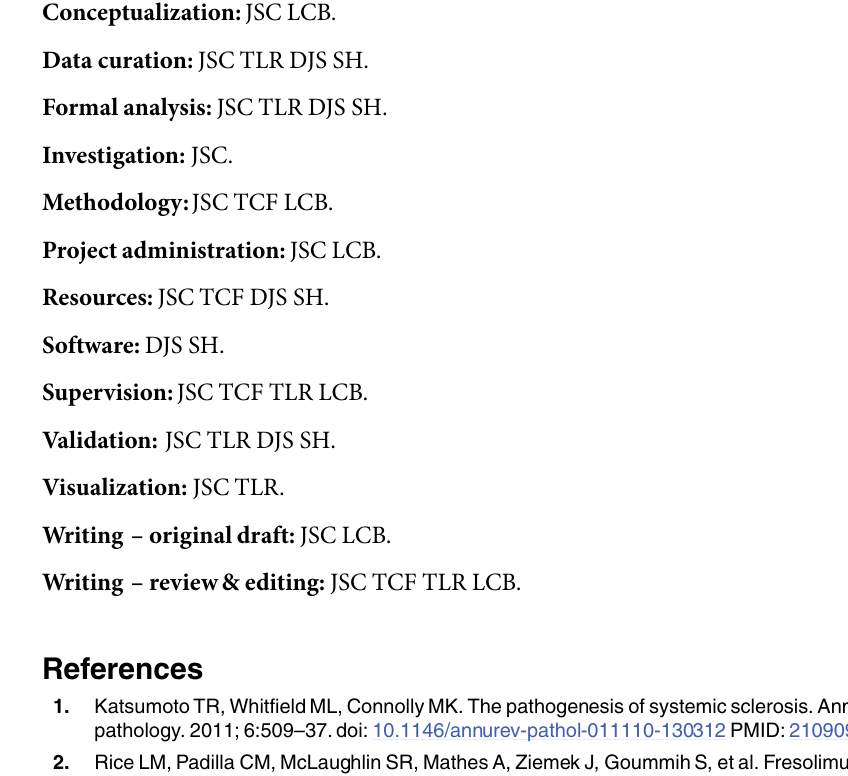
S7 Fig. Spearman rank correlation and ROC analysis of monocyte/macrophage cell recruit- ment and vessel density with ulceration area. (A-B) A scatter plot of all treatment groups that were analyzed by spearman rank correlation is shown for IBA-1 (A) and CD31 (B) percent area immunoreactivity compared to area of ulceration (r = 0.56 for IBA-1 and r = 0.33 for s s CD31). (C) The logistic regression and ROC curve analyses were applied to evaluate the predic- tive accuracy of IBA-1, CD31, or the combination of IBA-1 and CD31 percent area immunore- activity for presence or absence of ulceration. P -values were calculated relative to the null hypothesis for IBA-1 and CD31 or relative to IBA-1 alone for the combination of IBA-1 and CD31 percent area. N = 8 samples per group, two independent studies, 104 total data points. (cid:3) P -value relative to IBA-1 percent area alone. (TIF) S8 Fig. Expression of ISGs in lesional skin biopsies obtained from wildtypeand IFNAR- deficient mice. Relative mRNA expression levels of MX1 , RSAD2 , IRF7 , or MDA5 from lesional skin homogenates of skin biopsies performed by Q-PCR on days 3 (top) or day 21 (bottom) of treatment regimen. (cid:3) P < 0.05, (cid:3)(cid:3) P < 0.01, (cid:3)(cid:3)(cid:3) P < 0.001, versus saline or for brack- eted comparisons shown (student’s t test).